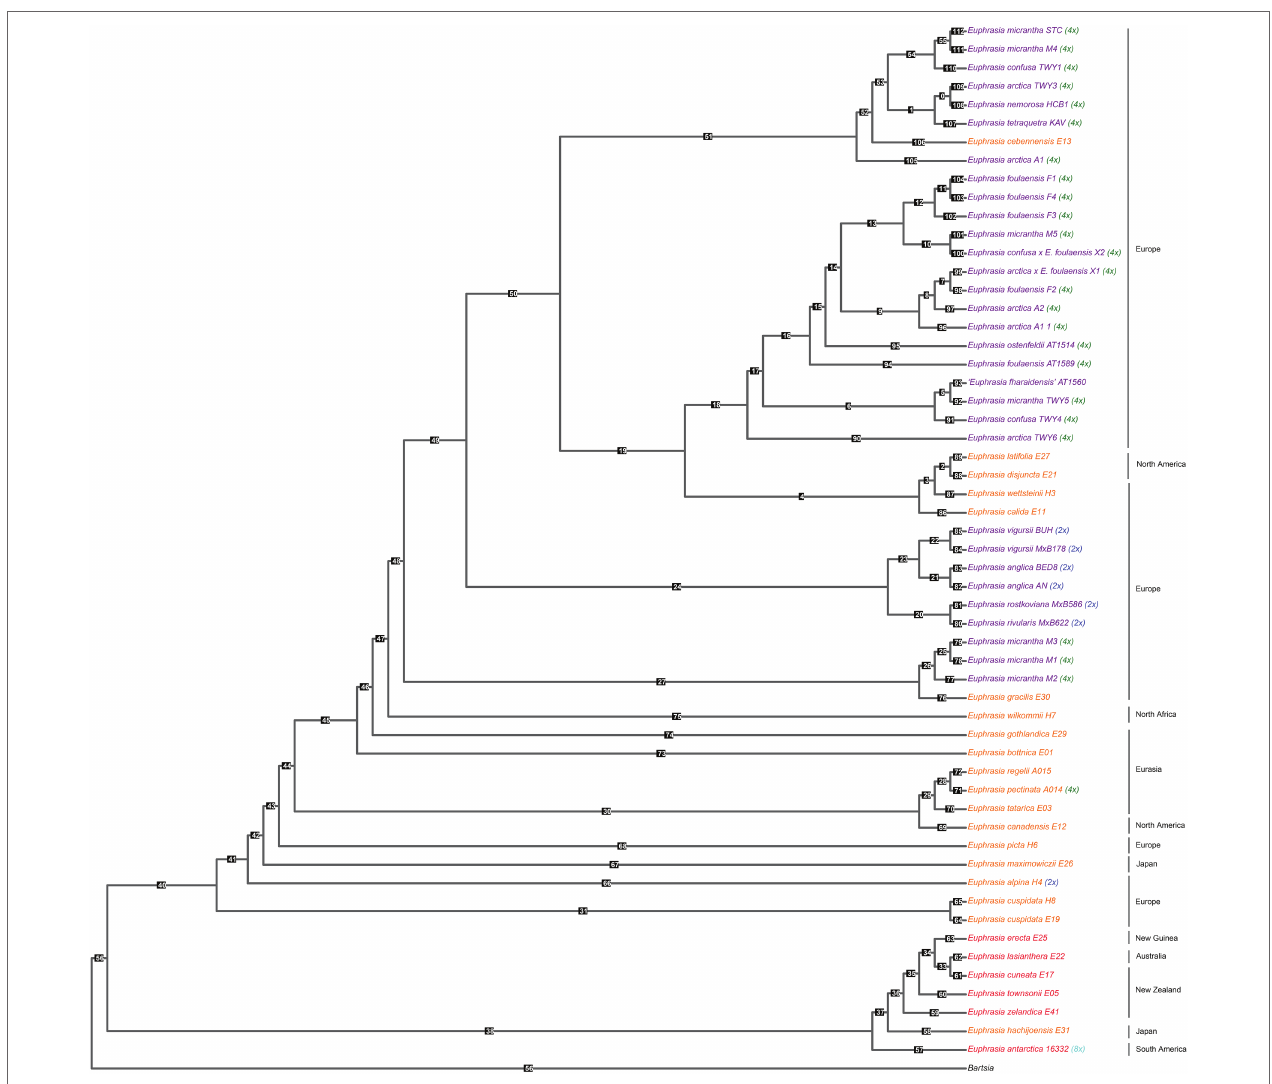
FIGURE 3 | Species tree built from conserved nuclear scaffolds present across Euphrasia species. Species tree performed using Astral, based on gene trees for each of 3,454 scaffolds (totaling 46 Mb) generated with IQTree 2. Tips colored by geography and labeled with ploidy as Figure 1 . Numbered branch labels correspond to separate bar plots quantifying discordance using Discovista, presented in Figure 4